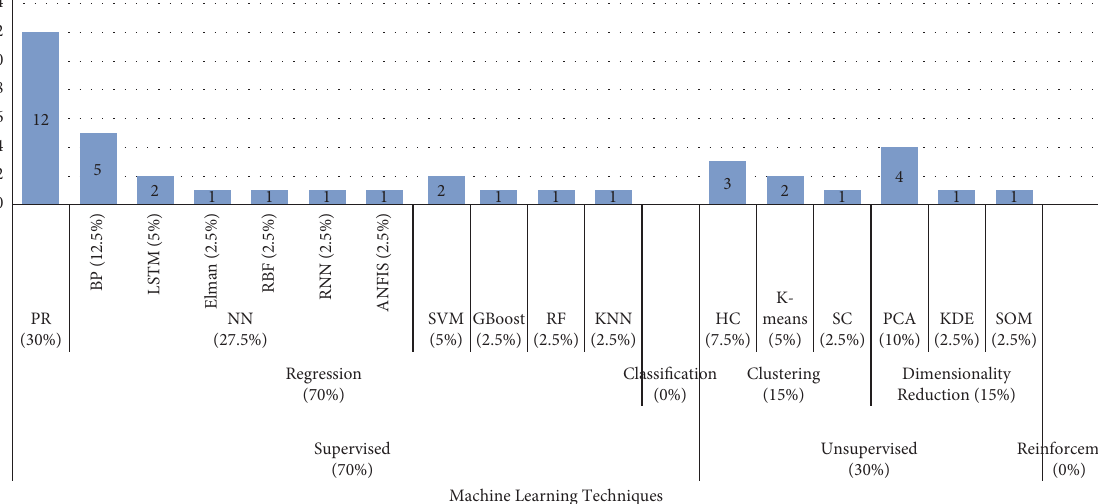
Figure 7: Categorization of ML techniques (subdomains, algorithms, and tools) for promoting environmental sustainability in port